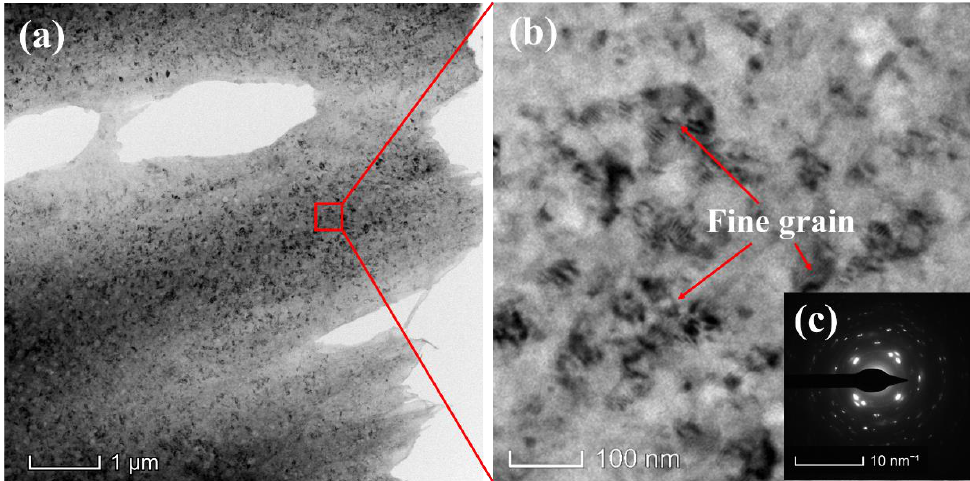
Figure 2. ( a , b ) Fine grains in bright-field TEM images of cryogenic MD-rolled alloy; ( c ) diffraction spot image.